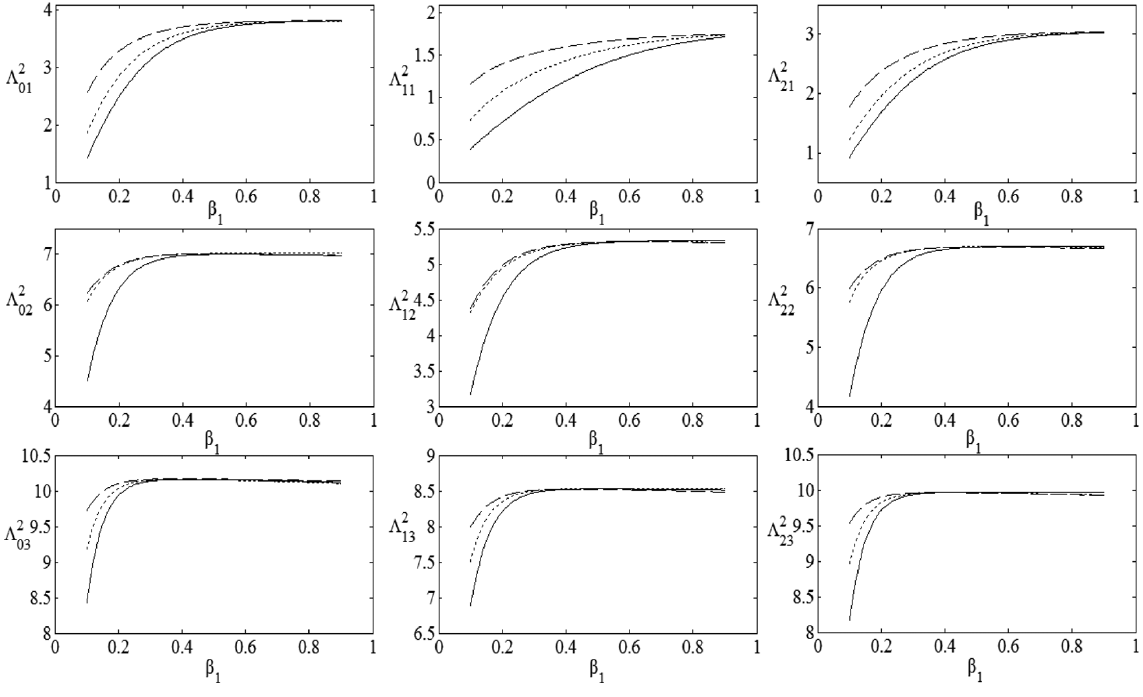
Fig. 4. Non-dimensional frequency parameters Λ 2 ml ( m = 0, 1, 2, l = 1, 2, 3) versus β 1 for β = 1 and three different α (—— α = 0.3, ······ α = 0.6, – – - α =